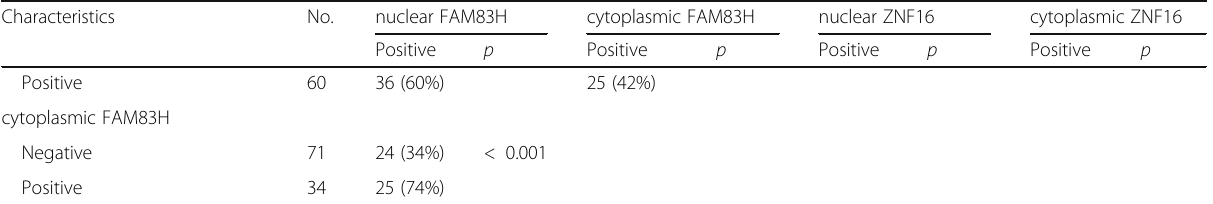
Table 1 Clinicopathologic variables and the expression of FAM83H and ZNF16 in gallbladder carcinomas (Continued) Characteristics